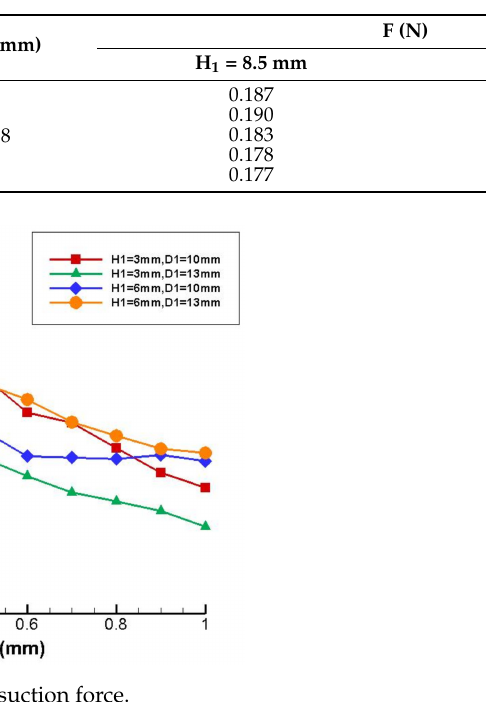
Table 1. The influence of θ on suction force.